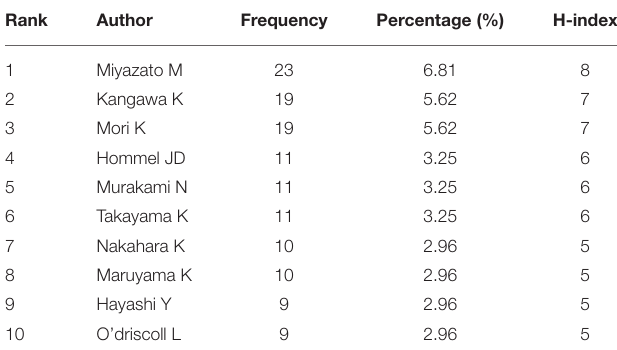
TABLE 5 | The top 10 authors contributed to the publications on NMU researches from 1987 to